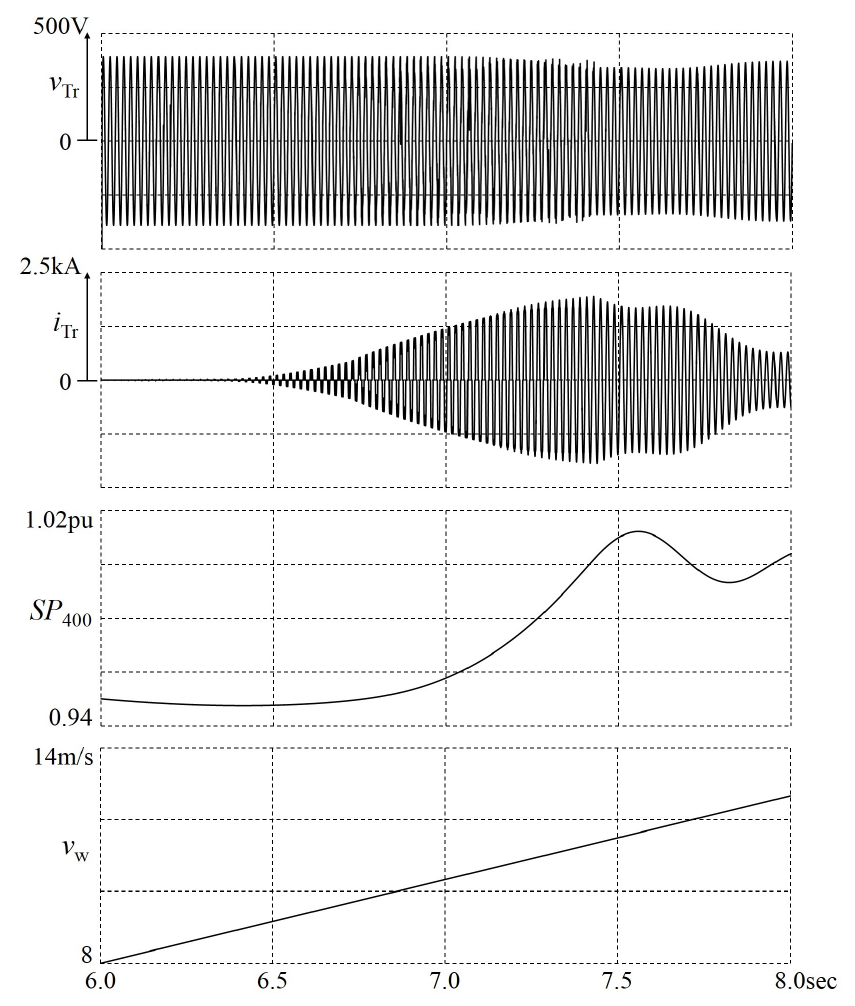
Figure 9. Simulated waveforms with a soft-starter for the 400-kW SCIM.